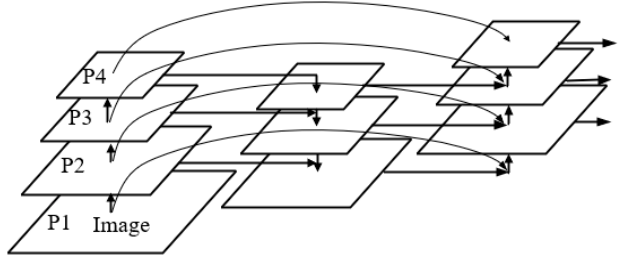
Figure 3. The structure of weighted feature fusion mechanism.